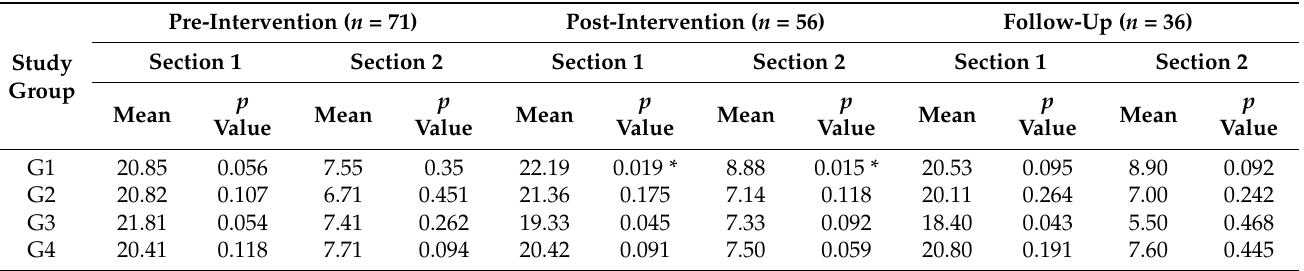
Table 2. Results per literacy questionnaire group: number of participants, significant differences, and means in each phase of the